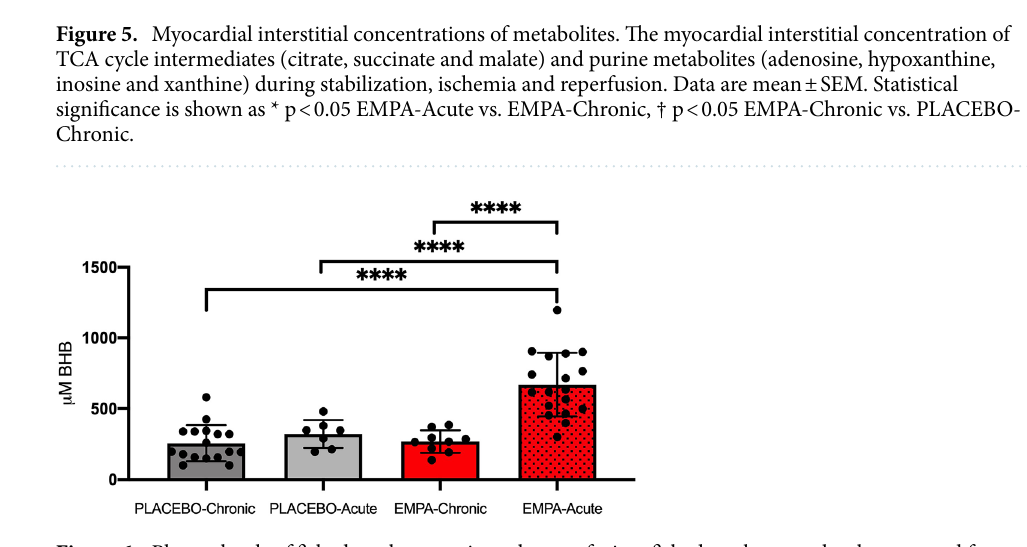
Figure 6. Plasma levels of β-hydroxybutyrate in early reperfusion. β-hydroxybutyrate levels measured from a venous blood sample after 2 h of reperfusion in. PLACEBO (n = 17), PLACEBO-Acute (n = 1.5), EMPA-Chronic (n = 18), EMPA1.5 (n = 9). BHB: β-hydroxybutyrate. Data are mean ± SD. Statistical significance is shown as **** p <